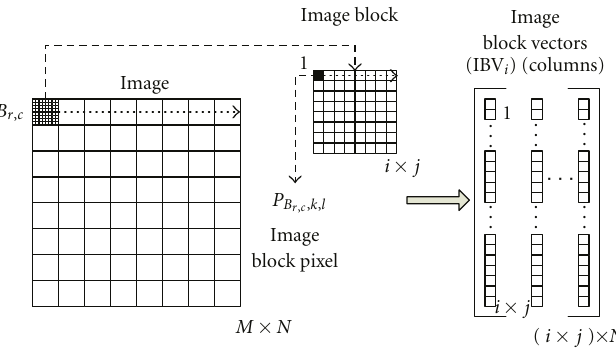
Figure 3: Decoding process.